Question: Generate an informative caption for the figure above.
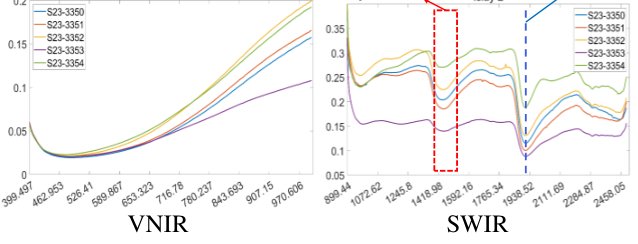
Answer: The mean spectra of a number of random pixels selected from 5 Islay